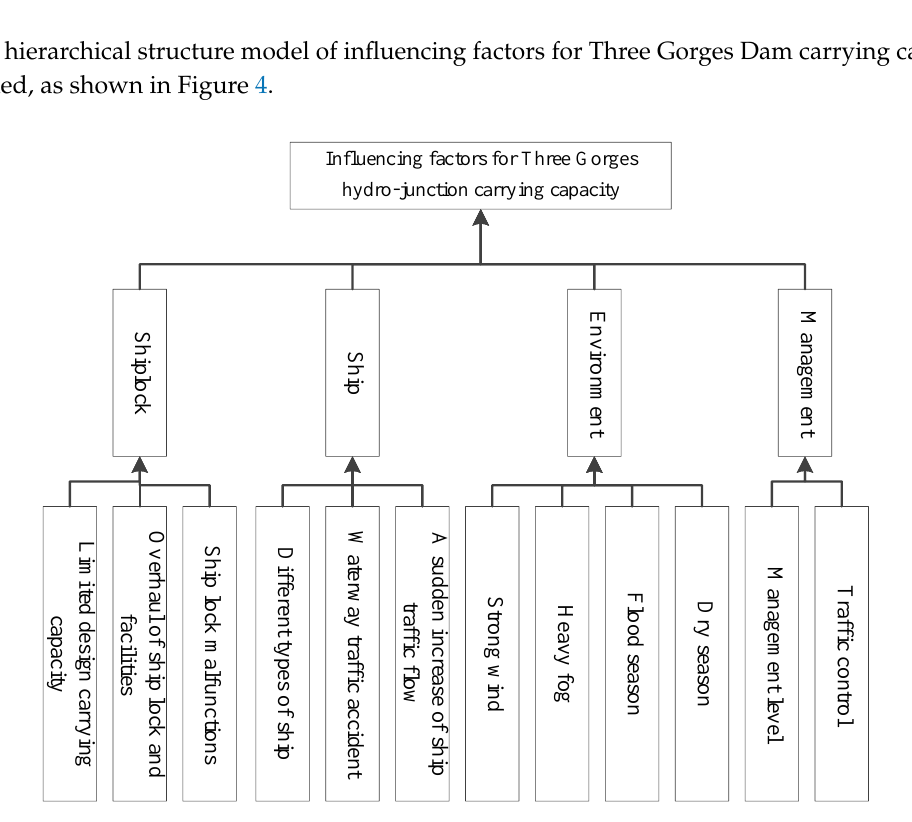
Figure 4. Hierarchical structure of influencing